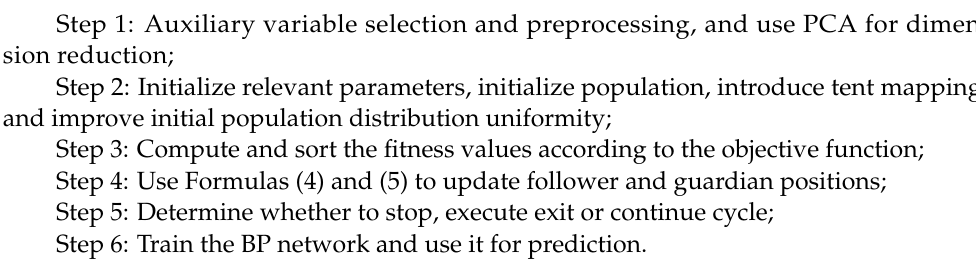
Figure 5. Flowchart of Tent-SSA-BP algorithm.